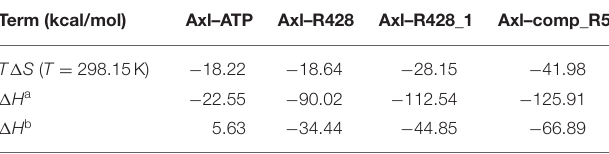
TABLE 10 | Entropy–enthalpy compensation analysis of the receptor–ligand complexes from 50 ns MD simulations. Term (kcal/mol)